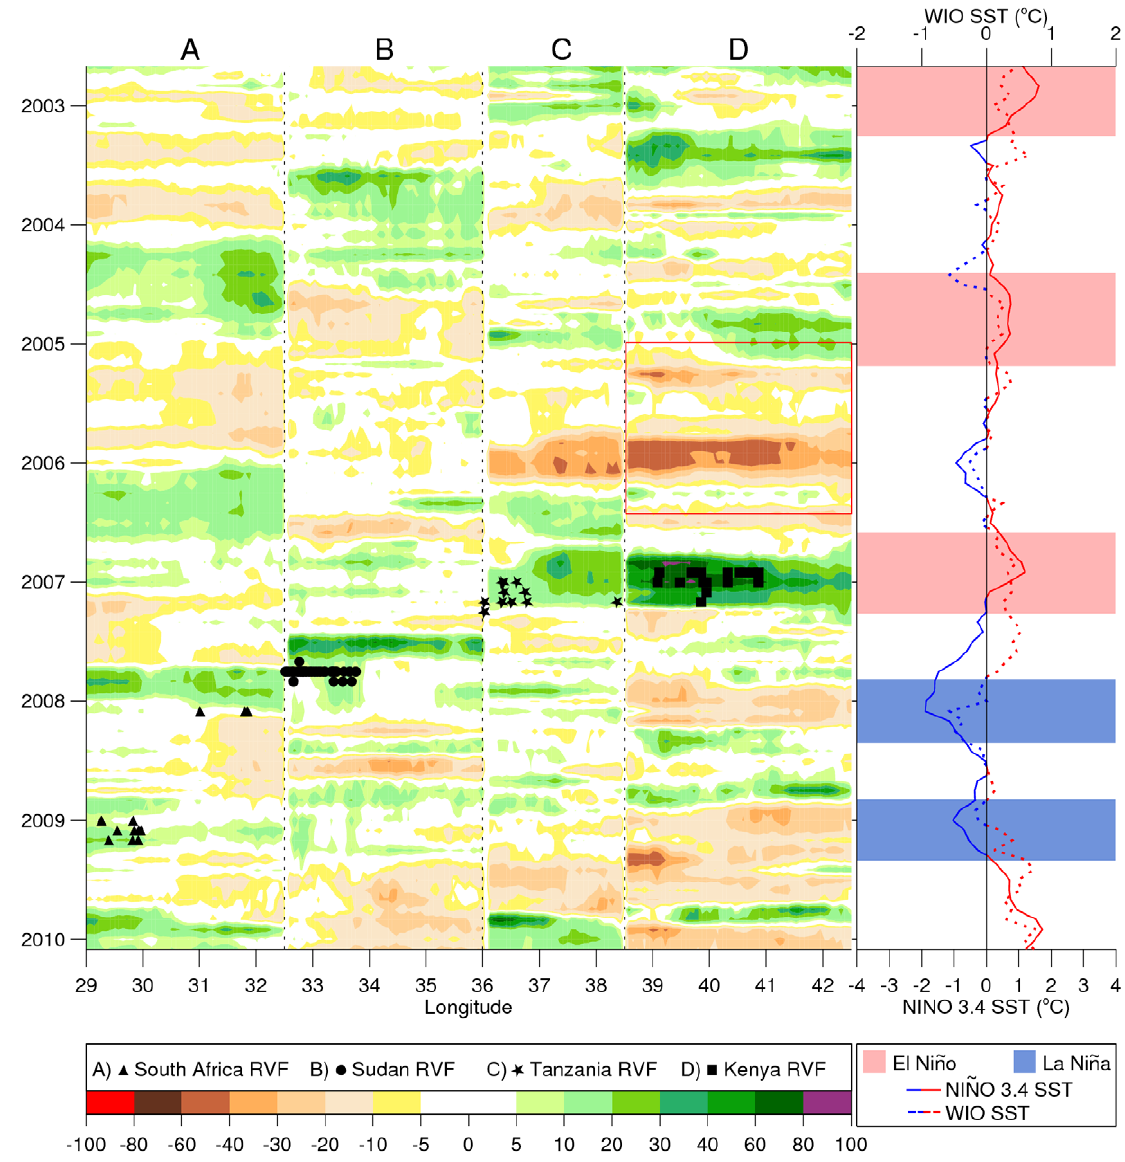
Figure 5. Spatial and temporal anomaly patterns of NDVI, SST in relation to RVF outbreaks. Spatial and temporal anomaly patterns in normalized difference vegetation index for selected areas of South Africa (A: 29 u E and 32.5 u E, averaged from 23 u S to 27 u S), Sudan (B: 32.5 u E and 34 u E, averaged from 11 u N to 15 u N), Tanzania (C: 34 u E and 37 u E, averaged from 4.5 u S to 8.5 u S) and Kenya (D: 37 u E and 42.5 u E, averaged from 2 u S to 2 u N). Regions were plotted by geographic position west to east and represent areas with dense concentrations of Rift Valley fever cases. NDVI anomalies are depicted as percent departures from the 2002–2008 long-term mean, and show the response of vegetation to variations in rainfall. Periods shaded in green to purple indicate above-normal vegetation conditions associated with above-normal rainfall. Periods of persistent drought or below normal rainfall are shown in shades of yellow to red. Each Rift Valley fever outbreak was preceded by above-normal vegetation conditions resulting from persistent above-normal rainfall in the Horn of Africa and Sudan in 2006–2007. Chikungunya epidemics occurred over East Africa and Indian Ocean islands during the 2005–2006 drought period shown by negative NDVI anomalies from 2005–2006 [D: red boxed area]. Clusters of epidemics/ epizootics of Rift Valley fever in East Africa (2006–2007) and Sudan (2007) occurred during the El Nin˜o event of 2006–2007 when there were concurrent anomalously warmer WIO and Nino 3.4 SSTs. The transition to La Nin˜a conditions in late 2007–early 2008 spatially shifted the area of above-normal rainfall and enhanced vegetation conditions to South Africa and Madagascar between February–March, 2008 and sporadically between February–March, 2009 in South Africa, leading to outbreaks of Rift Valley fever in these regions. This illustrates that spatial displacements in extreme rainfall and ecological conditions driven by large-scale climate mechanisms such as ENSO and regional circulation lead to spatial-temporal shifts in areas at risk for outbreaks of these mosquito-borne diseases. doi:10.1371/journal.pntd.0001465.g005 measurement. We coded Rift Valley fever presence with a 1 for the year of outbreak and absence with a 0 for all other years, and e ( b 0 z xi b 1) p i ~ , then ran a logit model regression of Rift Valley fever presence/ 1 z e ( b 0 z xi b 1) absence on cumulative rainfall anomaly. The logit model was